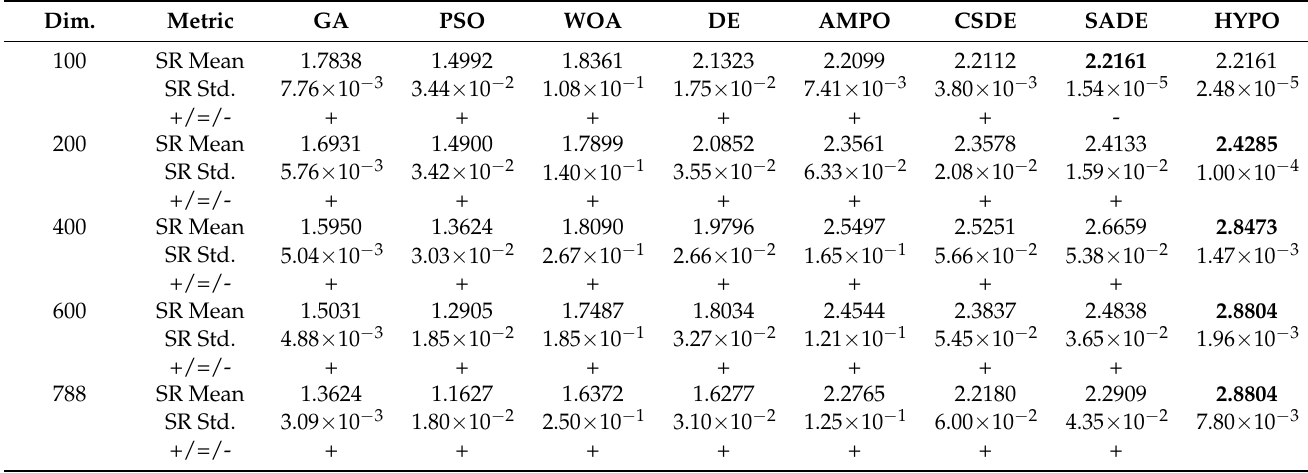
Table 8. Comparative Results on the Mixed Market Set.